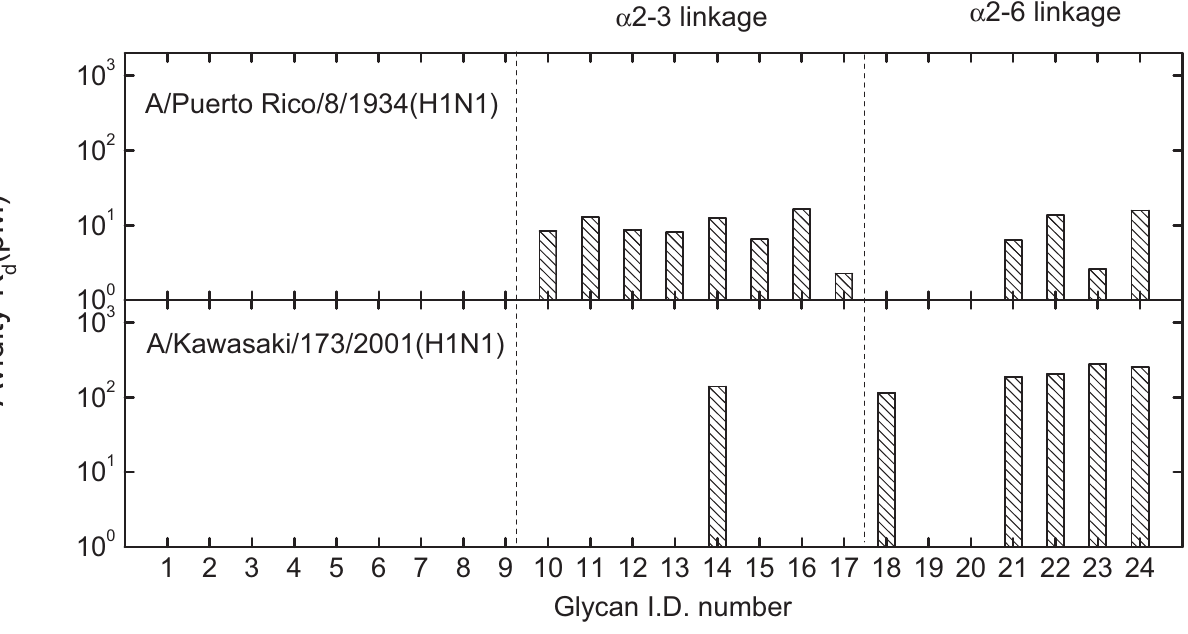
Figure 3. Avidity-enhanced equilibrium dissociation constants of two H1 influenza viruses, A/PR8 (top panel) and A/K173 (bottom panel), to the 24 glycans as listed in Table 1. A/PR8 binds to both α 2-3- and α 2-6-linked sialosides, while A/K173 preferentially recognizes α 2-6-linked sialosides. A/PR8 clearly binds to the glycan receptors more strongly than A/K173, A/Mem71, A/Udorn72 and